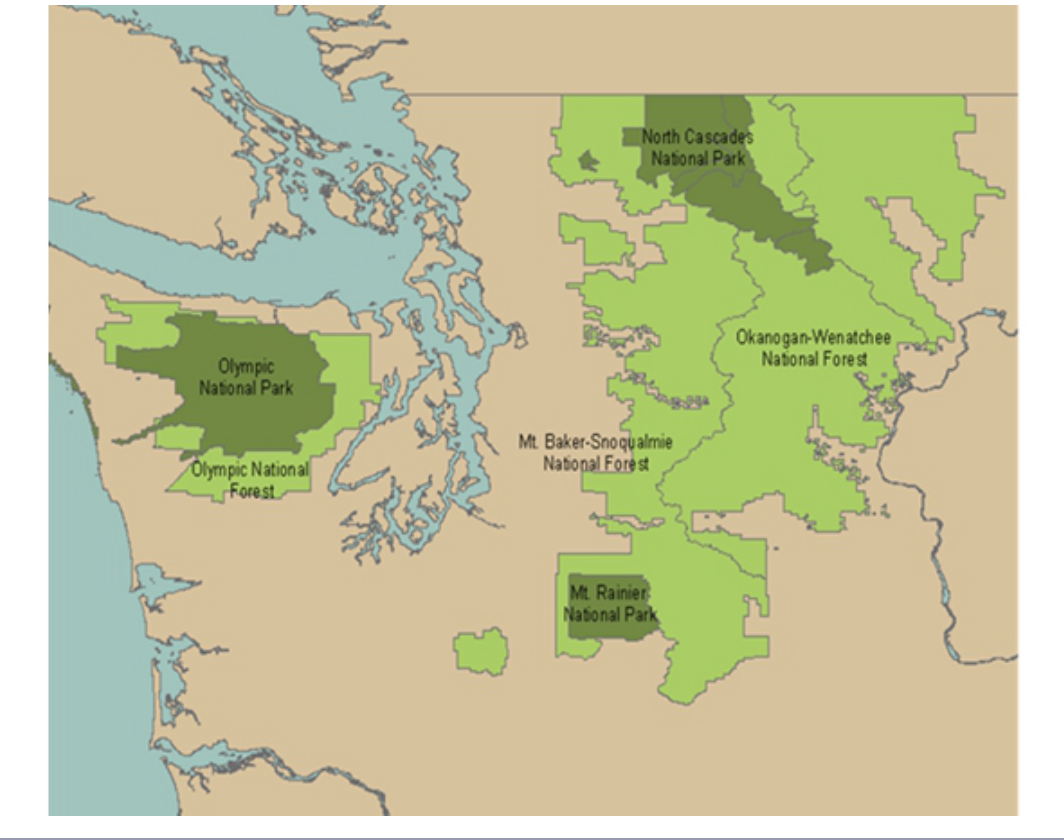
Fig. 1 . Geographic location of case study sites. This map was created from Washington State Department of Ecology and Department of Transportation Geographic Information Systems data (Washington State Department of Transportation 1994, Washington State Department of Transportation 1999 a , Washington State Department of Transportation 1999 b